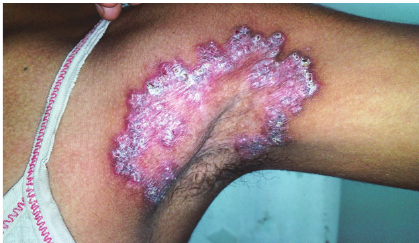
Figure 3: Erythematous scaly annular plaque in left axilla extending up to upper inner arm.